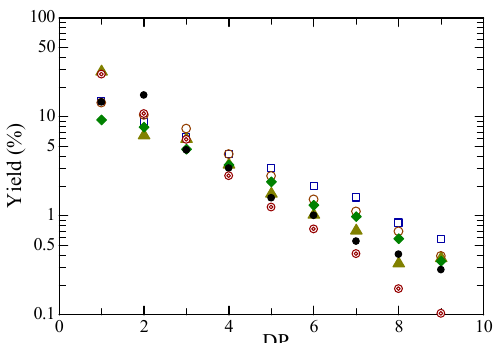
Figure 6. Product yield vs. degree of polymerization (DP) for pretreatment with various ionic liquids and BEDC, and untreated. The key is the same as in Figure 1.